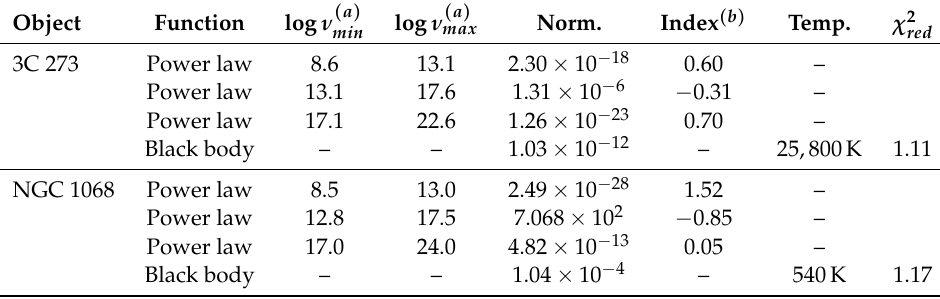
Table 2. Spectral energy distribution (SED) fitting